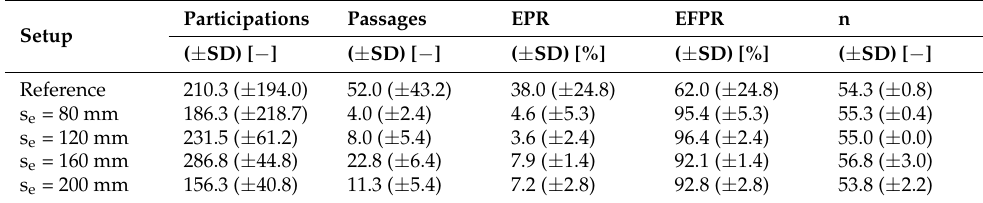
Table 2. Video analysis results of the ethohydraulic experiments: mean participations ( ± SD), mean passages ( ± SD), mean EPR ( ± SD), mean EFPR ( ± SD) and mean number of stocked individuals n ( ± SD) . Mean over the four conducted experiments in each setup (N = 4).